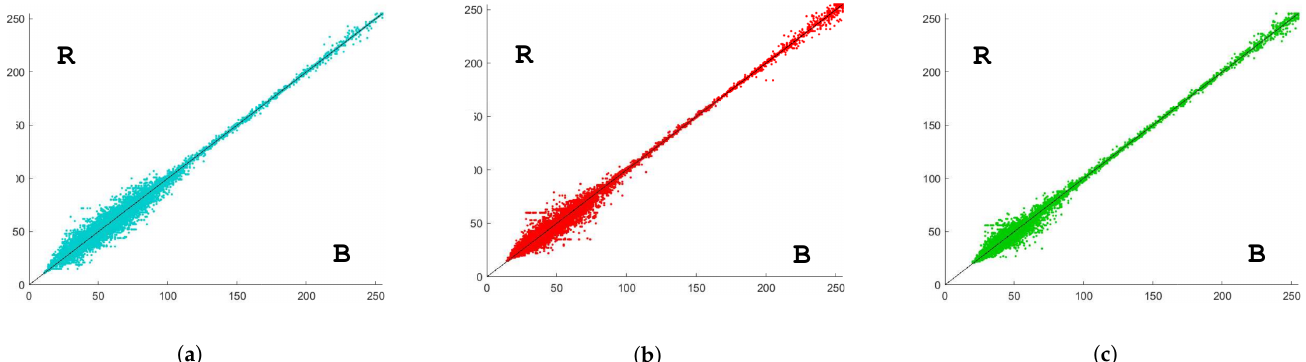
Figure 14. NRG self-validation test—HM based reconstruction; B = Base intensity values, R = Reconstructed intensity values. ( a ) scatter plot of Near-infrared values; ( b ) scatter plot of Red values; ( c ) scatter plot of Green values.